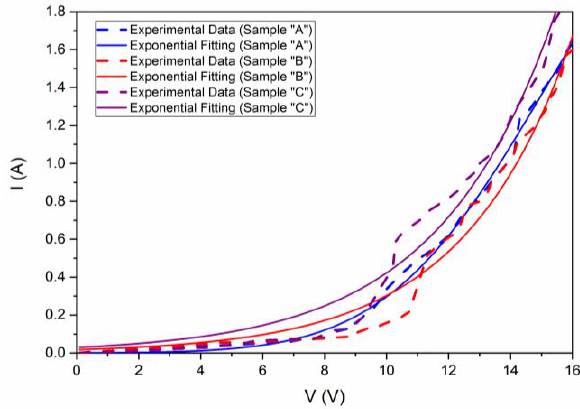
Figure 5. Current–voltage (I-V) characteristics of the CNP-based graphite samples.